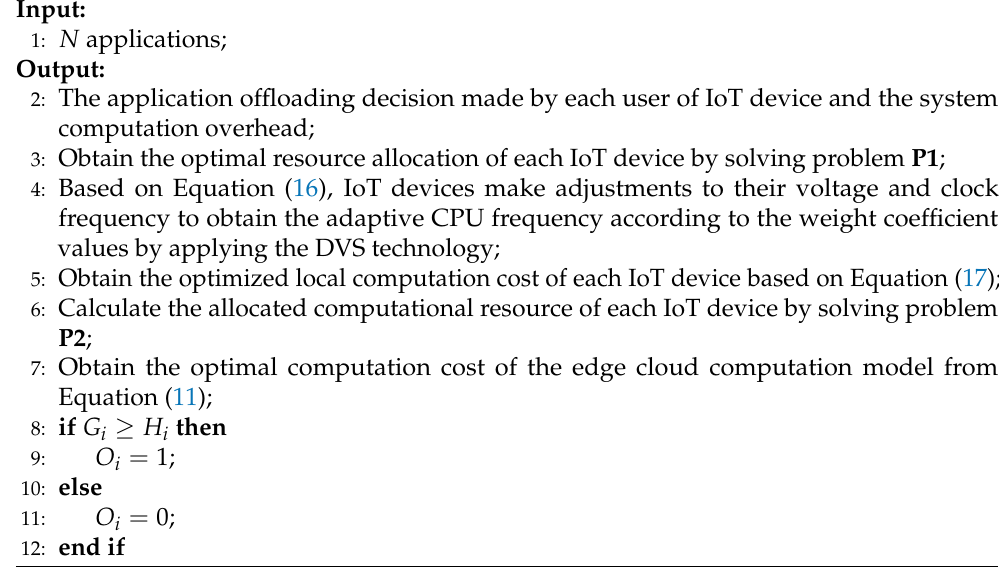
Algorithm 1 Computational Resource Allocation and Applications Offloading